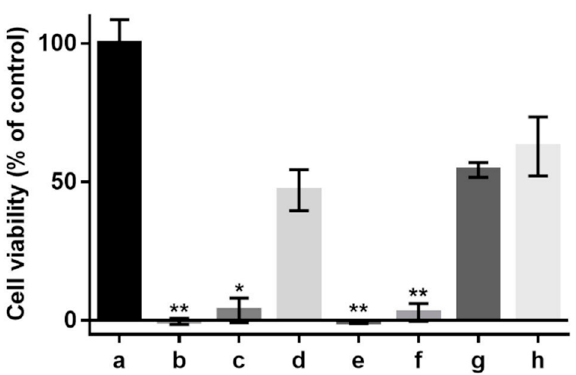
Figure 5. Effect of supplementation with sericin fractions on viability of 661 W murine retinal photoreceptor cells cultured in DMEM/10% FBS, without or in the presence of hydrogen peroxide (H202, 1.2 mM). ( a ) Control (no sericin, no oxidant); ( b ) control (no sericin, +oxidant); ( c ) CS, 1 mg/mL (+oxidant); ( d ) CS, 5 mg/mL (+oxidant); ( e ) PS, 1 mg/mL (+oxidant); ( f ) PS, 5 mg/mL (+oxidant); ( g ) CS-E, 1 mg/mL (+oxidant); ( h ) CS-E, 5 mg/mL (+oxidant). Bars represent mean values ± s. d. for n = 6. Statistical analysis was performed using the non-parametric Friedman test with Dunn’s multiple comparisons test. * p < 0.02; ** p < 0.002. The differences between cell viabilities in the control culture ( a ) and test culture samples ( d , g , h ) are not statistically significant ( p > 0.2).